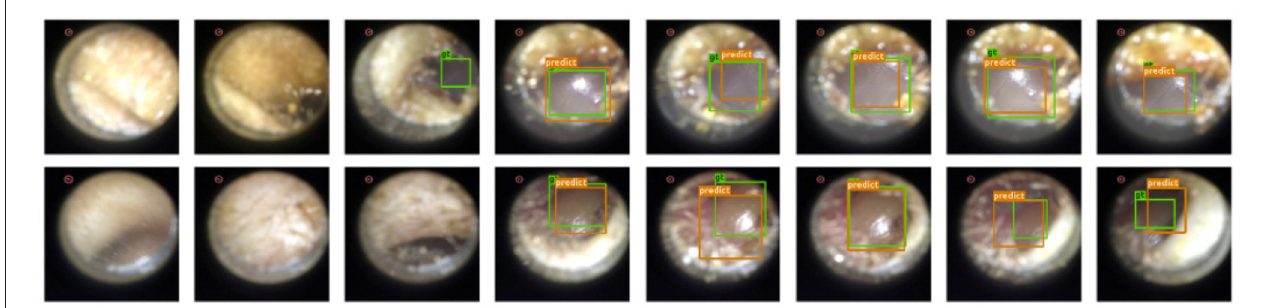
FIGURE 4 | Our detection module successfully extracts eardrum regions in video sequences. Green bounding box represents groundtruth eardrum region; orange bounding box represents detected eardrum region. Top Row: Normal video example. Bottom Row: Abnormal video example.